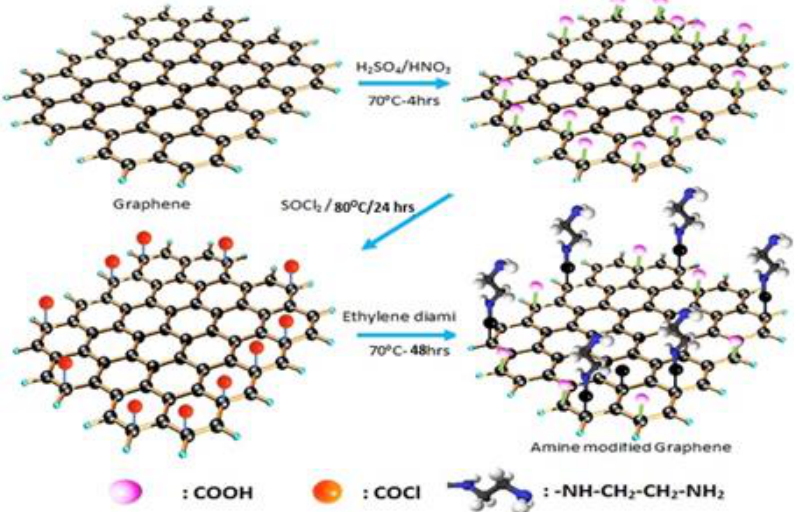
Figure 10. Different steps involved in the amine functionalisation of xGnP. Reprinted from Water Research, Volume 103, J.A. Prince, S. Bhuvana, V. Anbharasi, N. Ayyanar, K.V.K. Boodhoo, G. Singh, Ultra-wetting graphene-based PES ultrafiltration membrane—A novel approach for successful oil-water separation, Pages No. 311, Copyright (2016), with permission from Elsevier. [102].